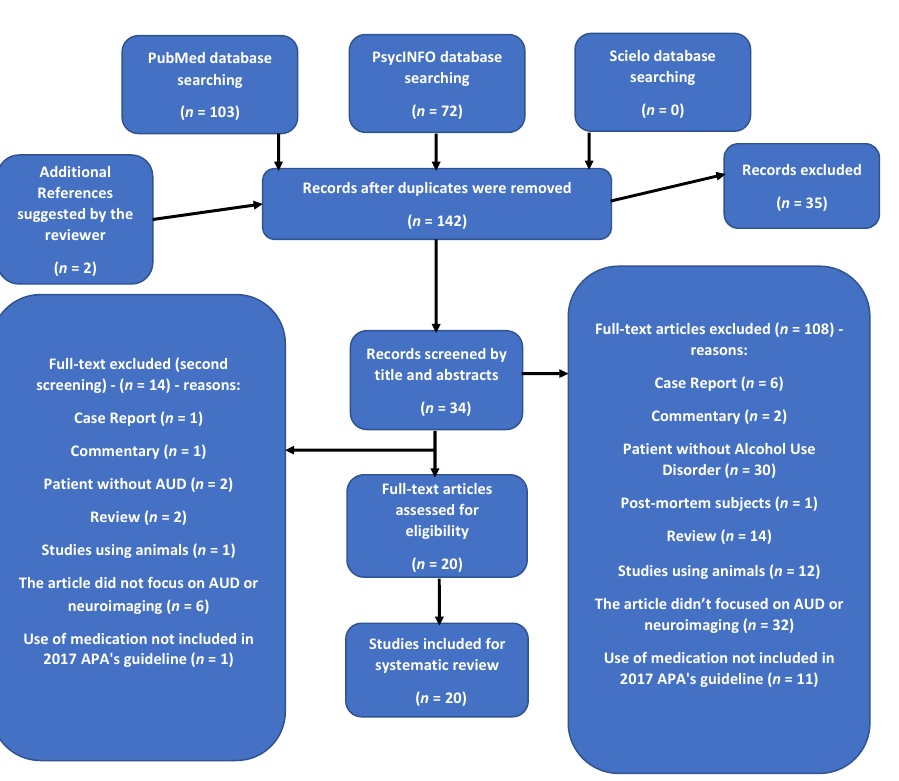
Figure 1. PRISMA illustrating the screening process applied in the study. Table 2. Treatment characteristics of each study, including duration, neuroimage exam utilized, fol- low-up, and measures used .